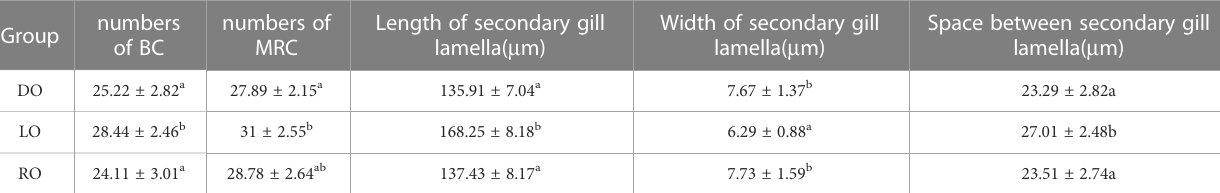
TABLE 2 Indices of gill tissue after 5 days of hypoxia and 5 days of reoxygenation.